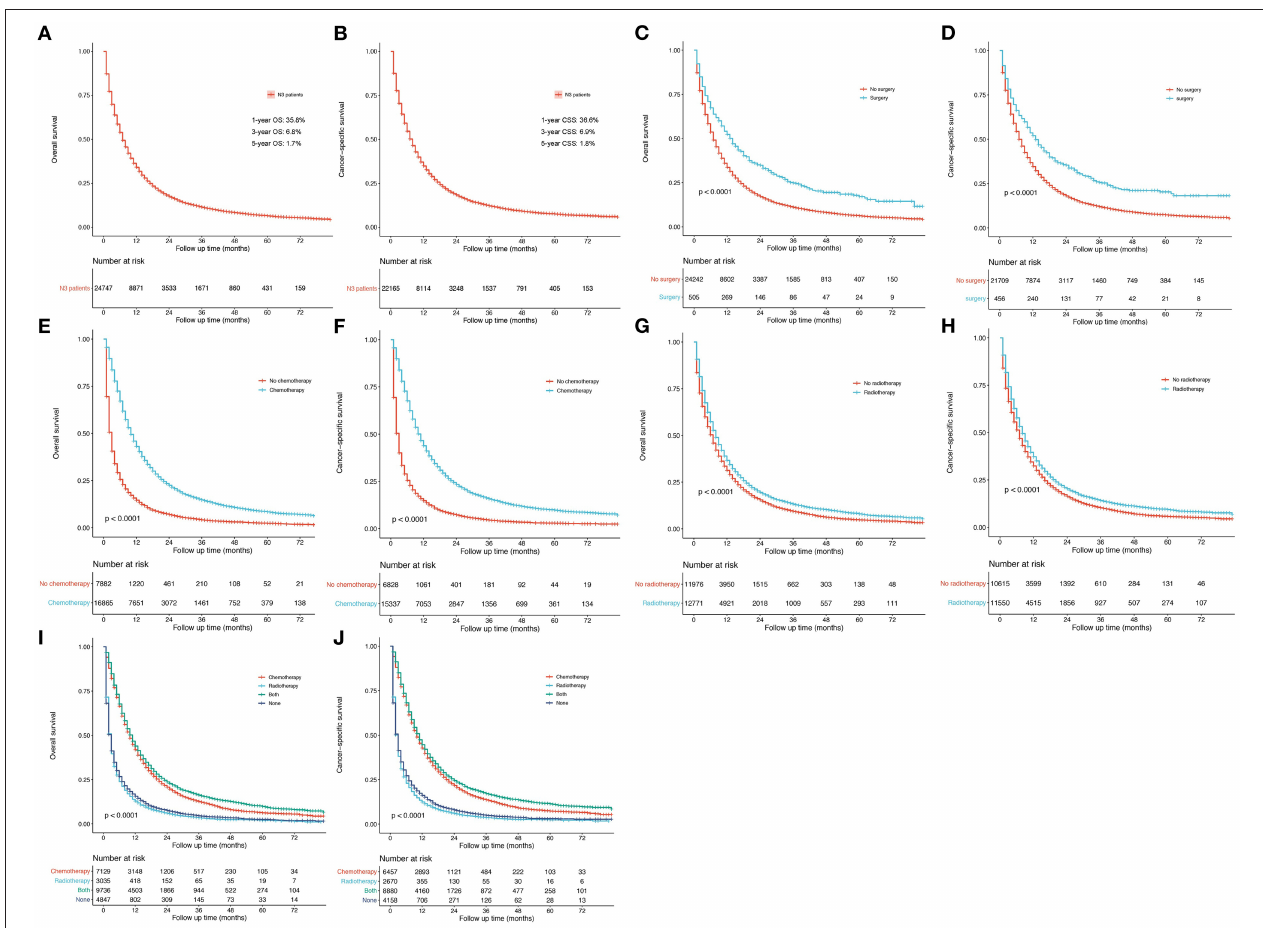
FIGURE 6 | Survival curves. (A,B) OS and lung cancer-specific OS for all N3-NSCLC patients. (C,D) Surgery vs. no surgery. (E,F) Chemotherapy vs. no chemotherapy. (G,H) Radiotherapy vs. no radiotherapy. (I,J) Groups distributed by systematic therapy (only chemotherapy, only radiotherapy, both, and